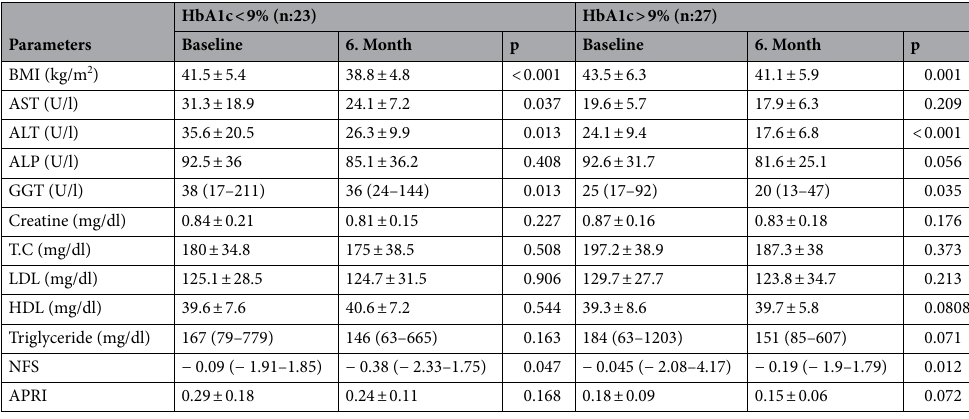
Table 5. Demographic and clinical data of the patients before and after exenatide therapy into HbA1c. BMI Body mass indeks, AST Aspartate aminotransferase, ALT Alanine aminotransferase, ALP Alkaline